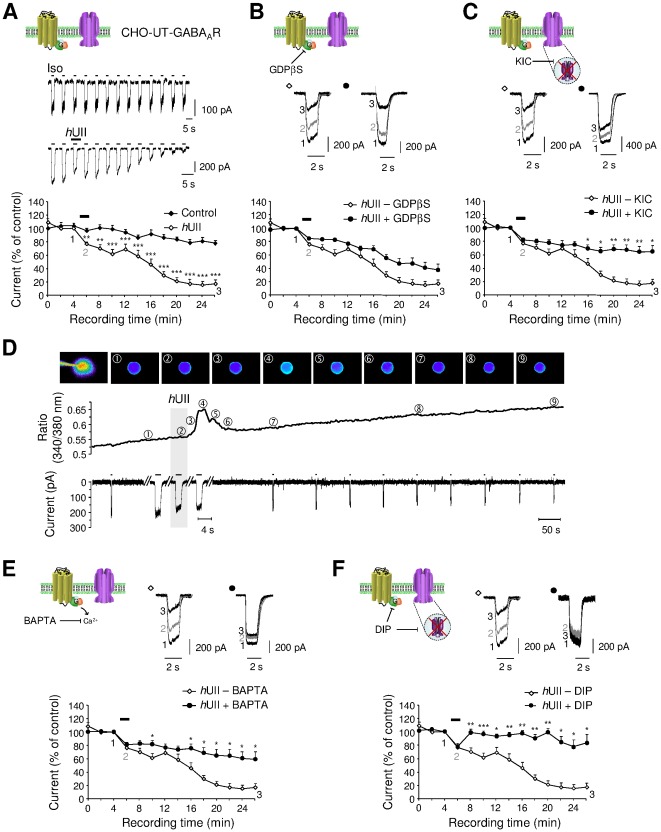
Intracellular mechanisms of UT-triggering GABAAR inhibition.(A) Traces of Iso (10−4 M, 2 s)-evoked current amplitude time-course on CHO-UT-GABAAR, in control (above row) or during a 1-min application of hUII (10−8 M, bottom row). Corresponding average time course of the Iso-evoked current, in control or during and after hUII application. (B, C) Current traces before (1), during (2) a 1-min hUII application and after 20-min washout (3), in the absence or presence of GDPβS (B, 10−4 M, 15 min of dialysis) or the cocktail of kinase and phosphatase inhibitors (C, KIC, 15 min of dialysis). Note that the KIC composition consists in phosphatase inhibitor cocktail at 5 mg/ml (sodium vanadate, sodium molibdate, sodium tartrate and imidazole), Quercetin (10 µM) and staurosporine (10 µM). In the bottom rows are represented the corresponding average time course of the Iso-evoked current, in the absence or presence of GDPβS (B) or KIC (C). (D) Representative [Ca2+]c (Fura-2 AM) imaging field before, during hUII application and during washout, and time-course of the fluorescence ratio 340/380. Numbers above each curve indicate the corresponding fluorescent image. The bottom row shows simultaneous currents evoked by repetitive Iso ejections, the time scale has been enlarged to show that the current inhibition occurs before hUII-induced [Ca2+]c rise. (E, F) Current traces before (1), during (2) a 1-min hUII application and after 20 min washout (3), in the absence or presence of the rapid Ca2+ chelator BAPTA (10−3 M, E) or the dynamin inhibitory peptide DIP (10−5 M, F). In the bottom rows are represented the corresponding average time course of the Iso-evoked current, in the absence or presence of BAPTA (E) or DIP (F). Data are mean ± SEM from 3 to 21 cells. *, P<0.05; ** P<0.01; *** P<0.001 compared with the corresponding control Iso-evoked current.